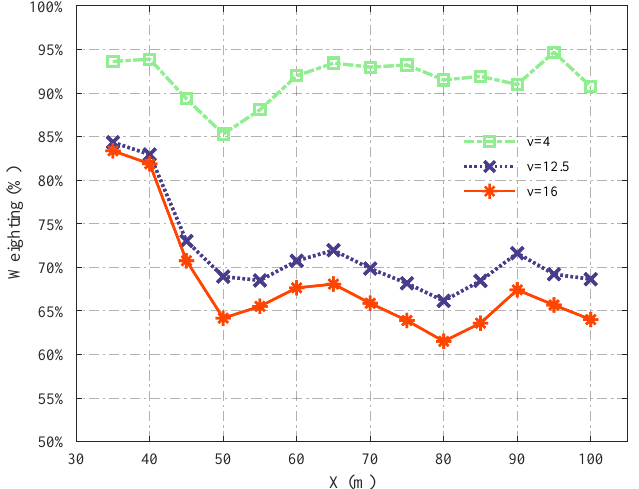
Figure 11. Percentage of particle mass within a height of 0 to 3 m-three